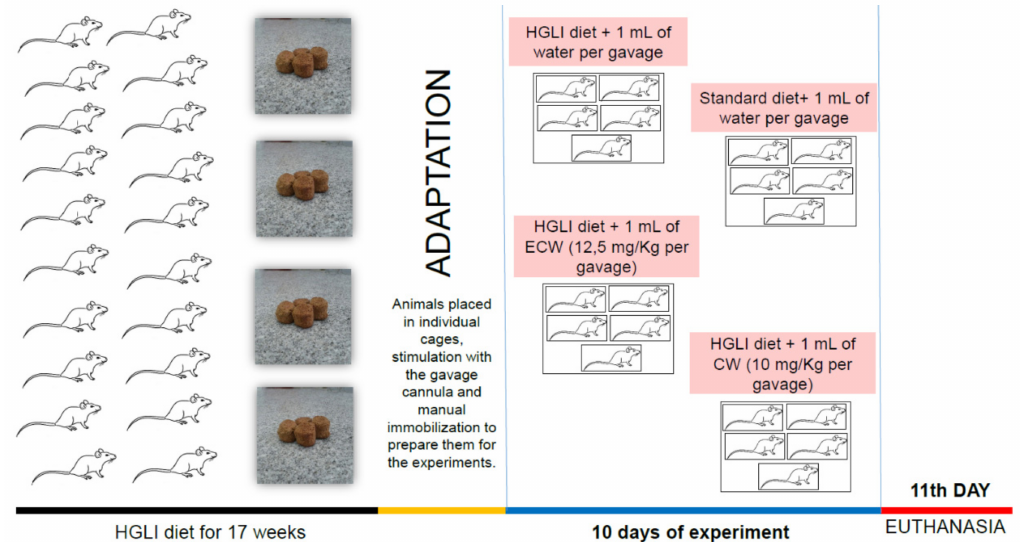
Figure 4. Experimental design summary. HGLI: high glycemic index and glycemic load diet; ECW trypsin inhibitor isolated from tamarind seeds encapsulated with whey protein isolate and chitosan (1:2:2 w/w/w ); CW: chitosan–whey protein isolate nanoparticles (2:2 w / w